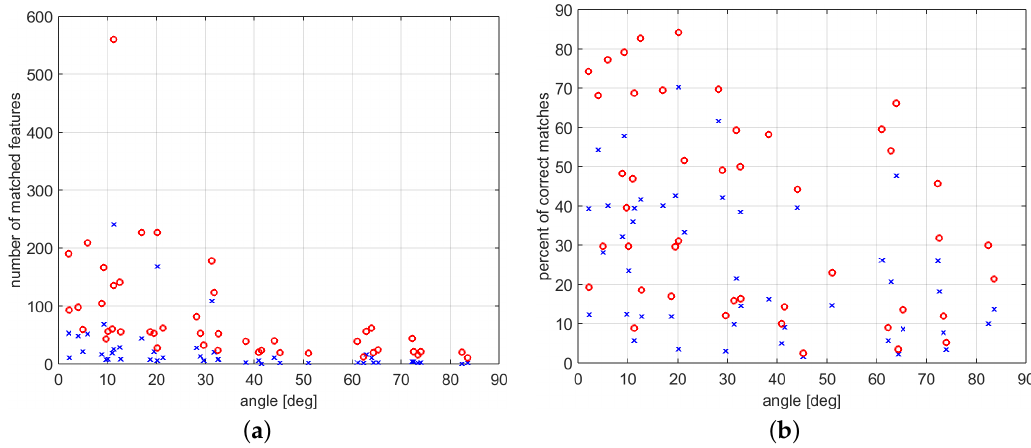
Figure 6. ( a ) number of correctly matched features and ( b ) percent of correctly matched features varying the angle between the camera poses. Comparison of number of matched features with standard SIFT ( blue crosses), and with the method proposed in Section 2 ( red circles) in the first case study.